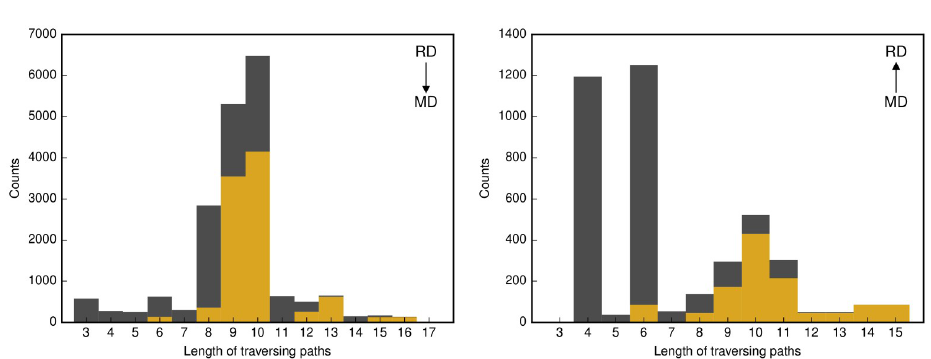
Fig 6. Distribution of the path lengths. Lengths are provided for the downwards (RD ! MD) and upwards traversing paths (MD ! RD), respectively (dark blue). The golden bars represent the fraction of downwards and upwards traversing paths comprising the PTS and RNR, and the NtrBC system associated